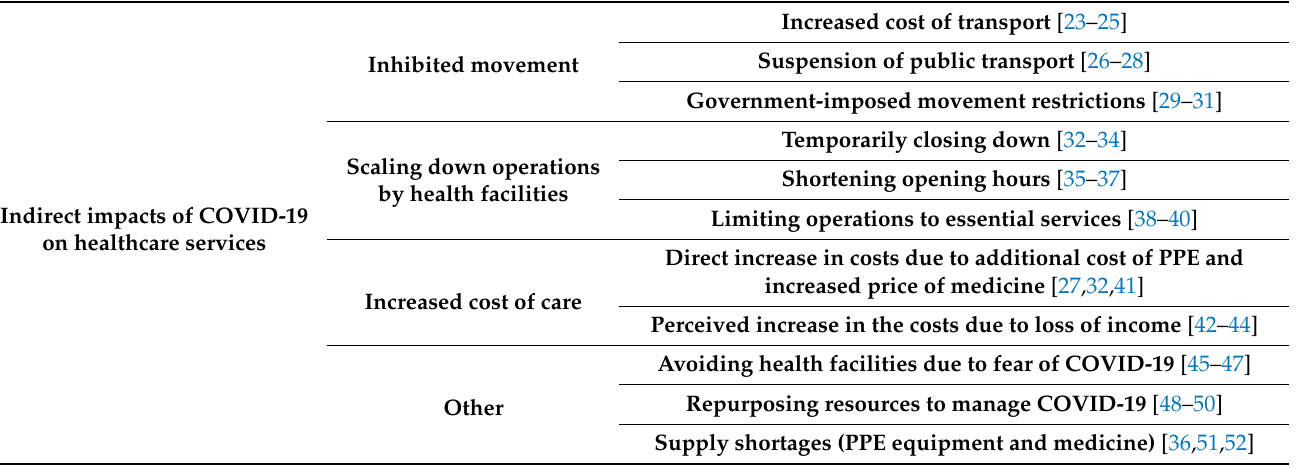
Table 2. Indirect impacts of COVID-19 on healthcare